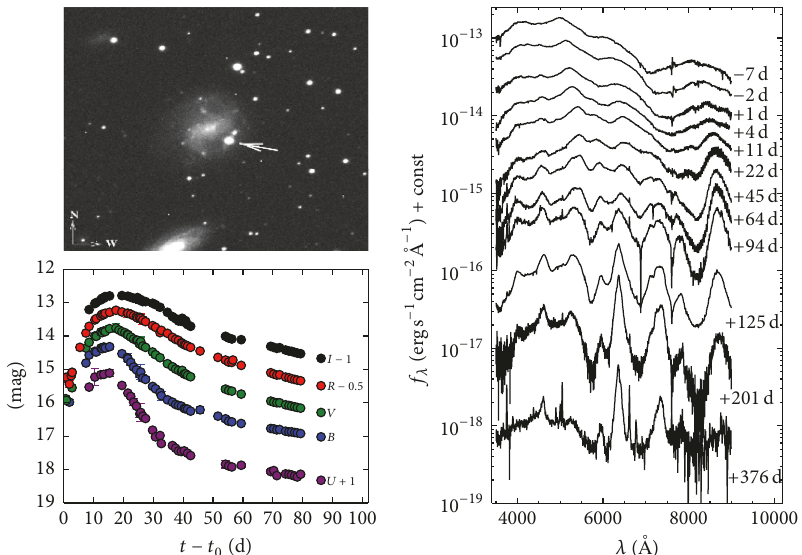
Figure 1: GRB 980425/SN 1998bw: the archetype GRB-SN. Host image (ESO 184-G82) is from [1], where the position of the optical transient is clearly visible. Optical light curves are from [9] and spectra from [2].